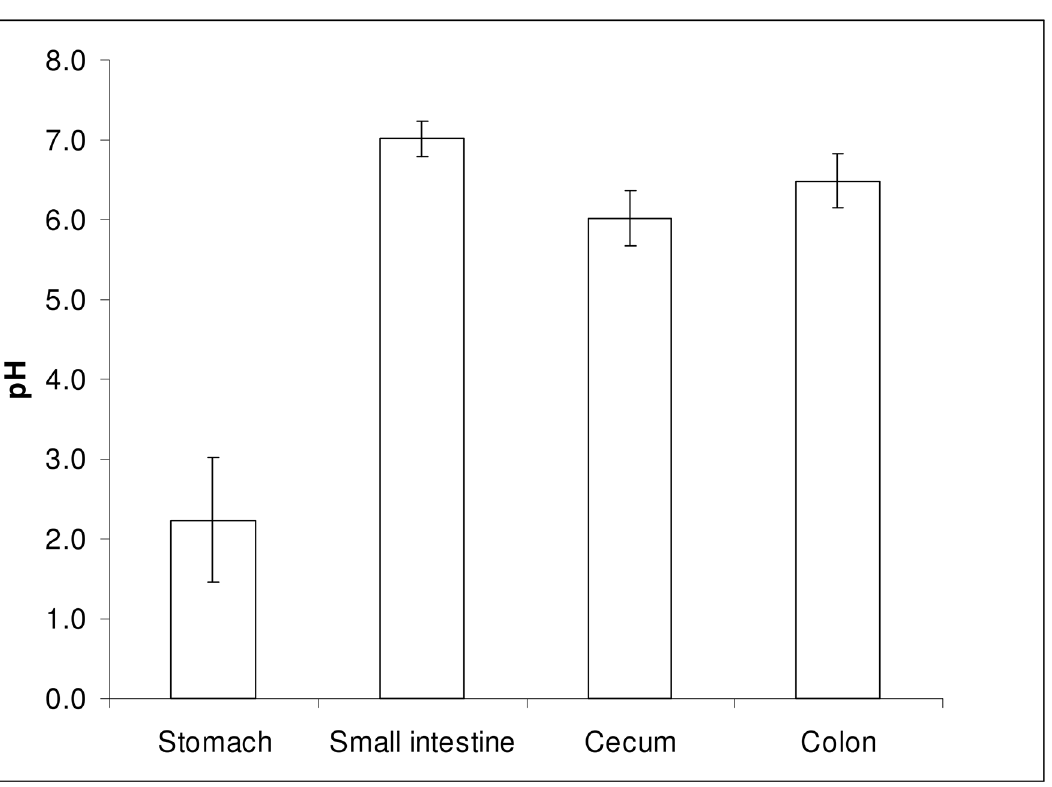
Fig 4. Summary of pH in the stomach, small intestine and colon as measured with the IntelliCap system. Data are presented as mean and standard deviation of 15 evaluable